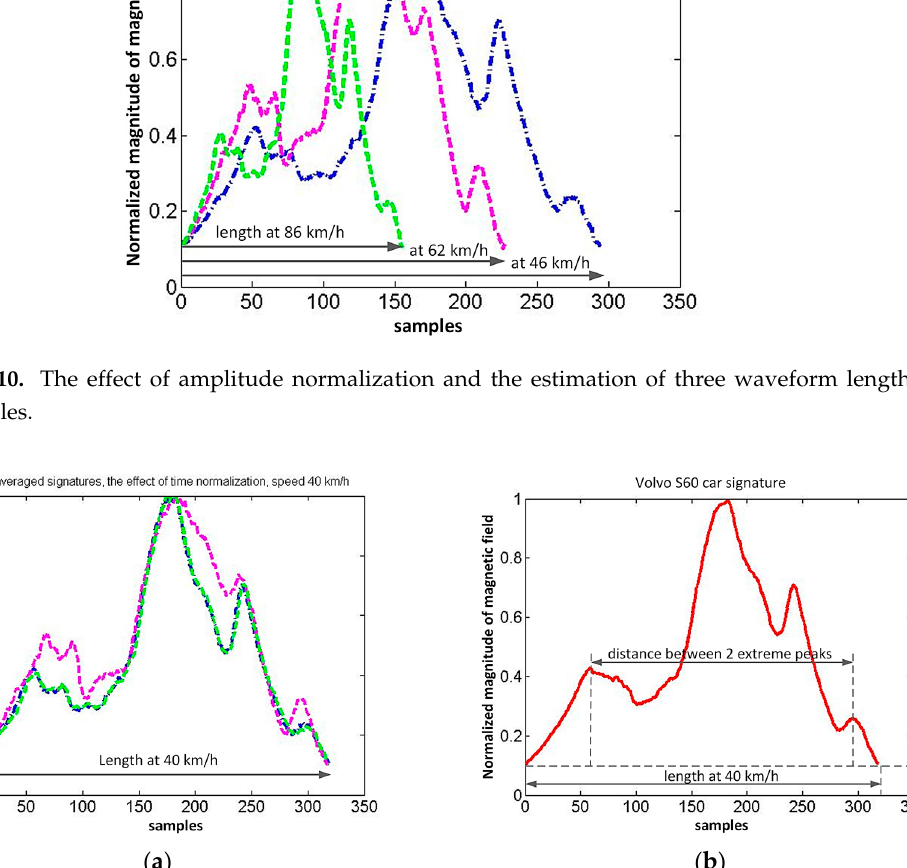
Figure 11. The effect of time normalization: ( a ) three waveforms have the same length after linear extrapolation to 40 km/h; ( b ) the average of three waveforms is a car signature, the distance between two extreme peaks is a measure of car length.